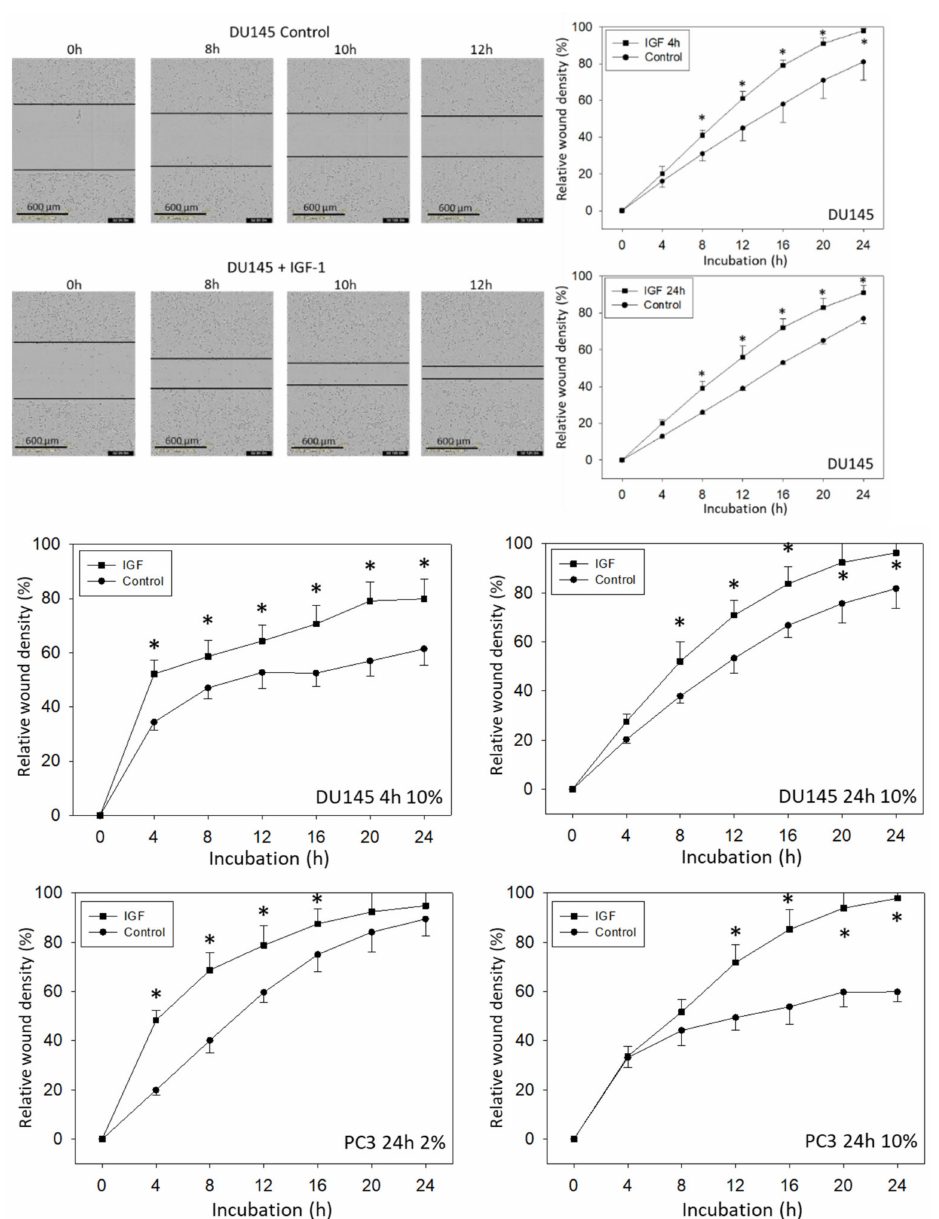
Figure 4. Motile crawling of DU145 and PC3 cells treated with IGF-1 (versus controls). The upper left side shows photomicrographs of the DU145 scratch assay taken after 0 (start), 8, 10, and 12 h (related to 4 h IGF-1 pre-stimulation). The upper right side shows the results from the quantitative calculation expressed as relative wound density (4 and 24 h pre-stimulation). DU145 were grown in 2% FBS. Lower panels: Relative wound density of DU145 cells following 4 or 24 h IGF-1 pre-stimulation and cultivation in 10% FBS, and relative wound density of PC3 cells stimulated with IGF-1 for 24 h and cultured in 2 or 10% FBS. Mean values of three experiments are shown. * indicates significant up-regulation compared to untreated controls ( n =